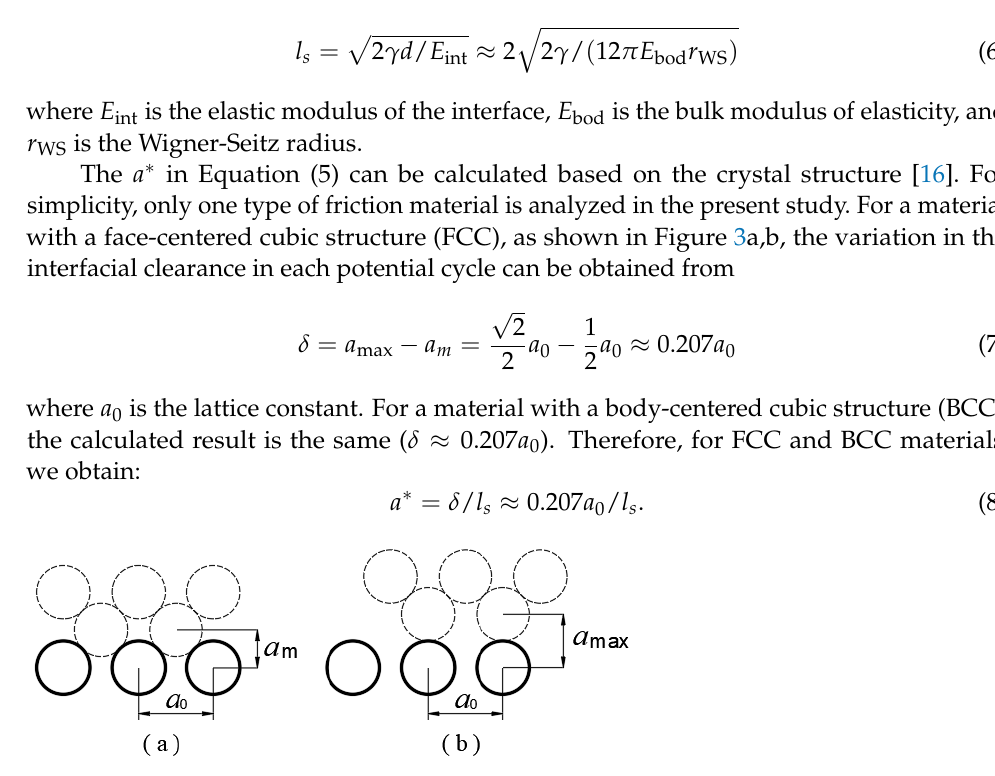
Figure 3. Diagram for calculation of variation in interfacial clearance. ( a ) Minimum clearance and ( b ) maximum clearance of FCC metals.